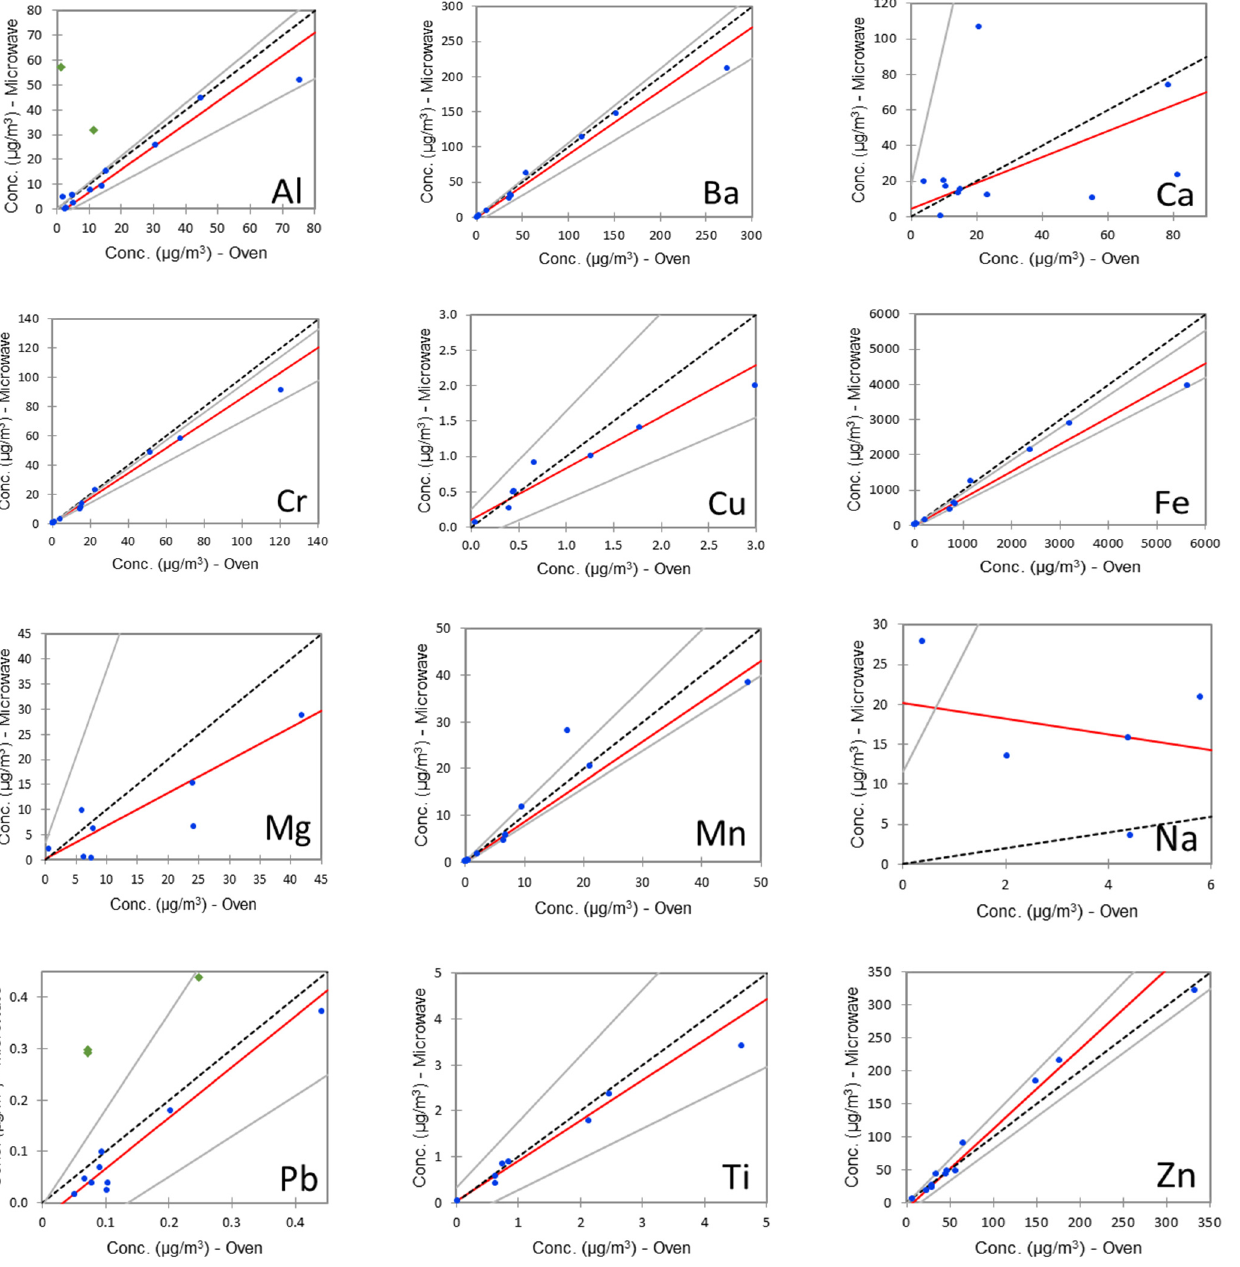
Figure 1. Regression models obtained with Passing–Bablok algorithm; points represented by diamonds were not included in model calculations. Table 4. Model coefficients obtained with Passing–Bablok regression at a confidence level of 95%.